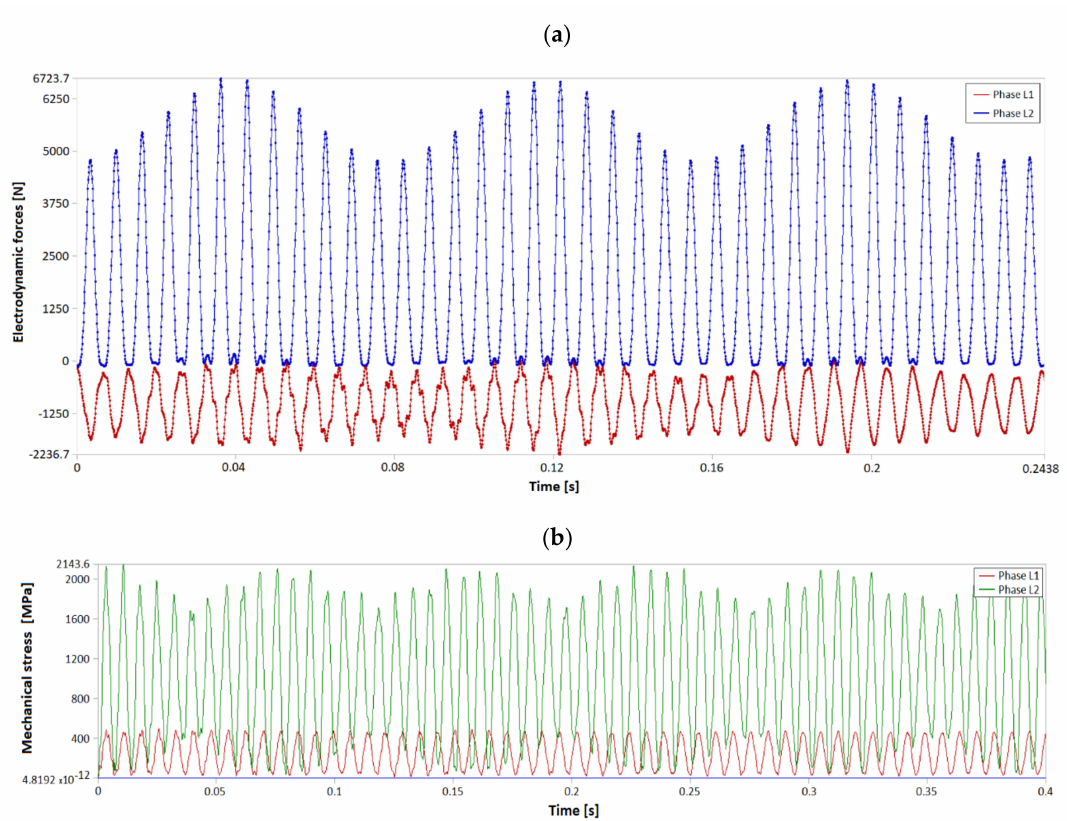
Figure 12. Simulation results for studied EIPB system (characteristics): ( a ) Electrodynamic forces characteristic; ( b ) mechanical stress characteristics.